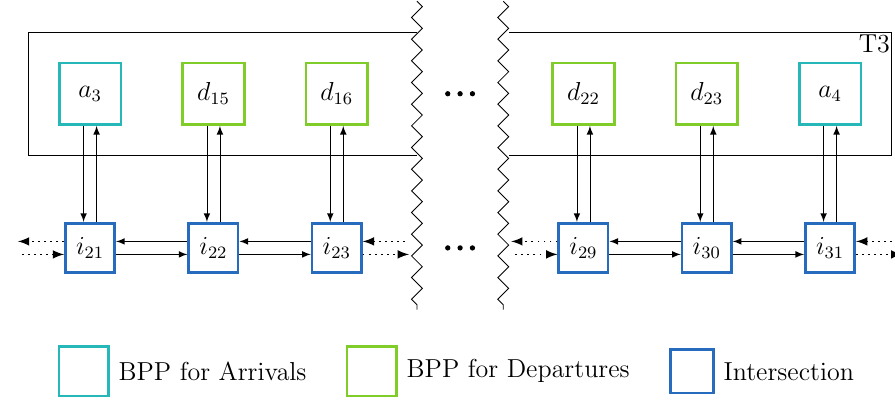
Figure 3. Detailed representation of Terminal